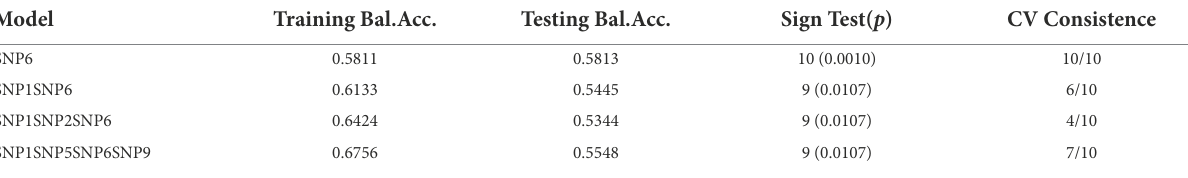
TABLE 4 MDR analysis of BCL11A SNPs showed different interactions for therapeutic response of patients with epilepsy. Model Training Bal.Acc. Testing